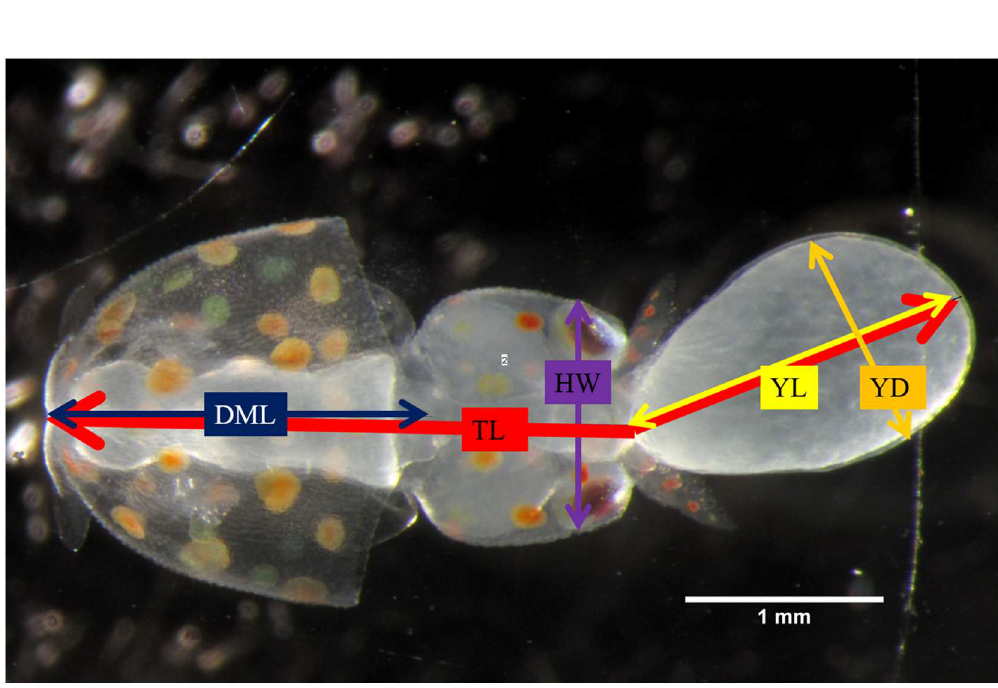
Fig 2. Embryo morphology. DML = Dorsal mantle length, TL = Total length, HW = Head width, YL = External yolk length, YD = External yolk diameter.